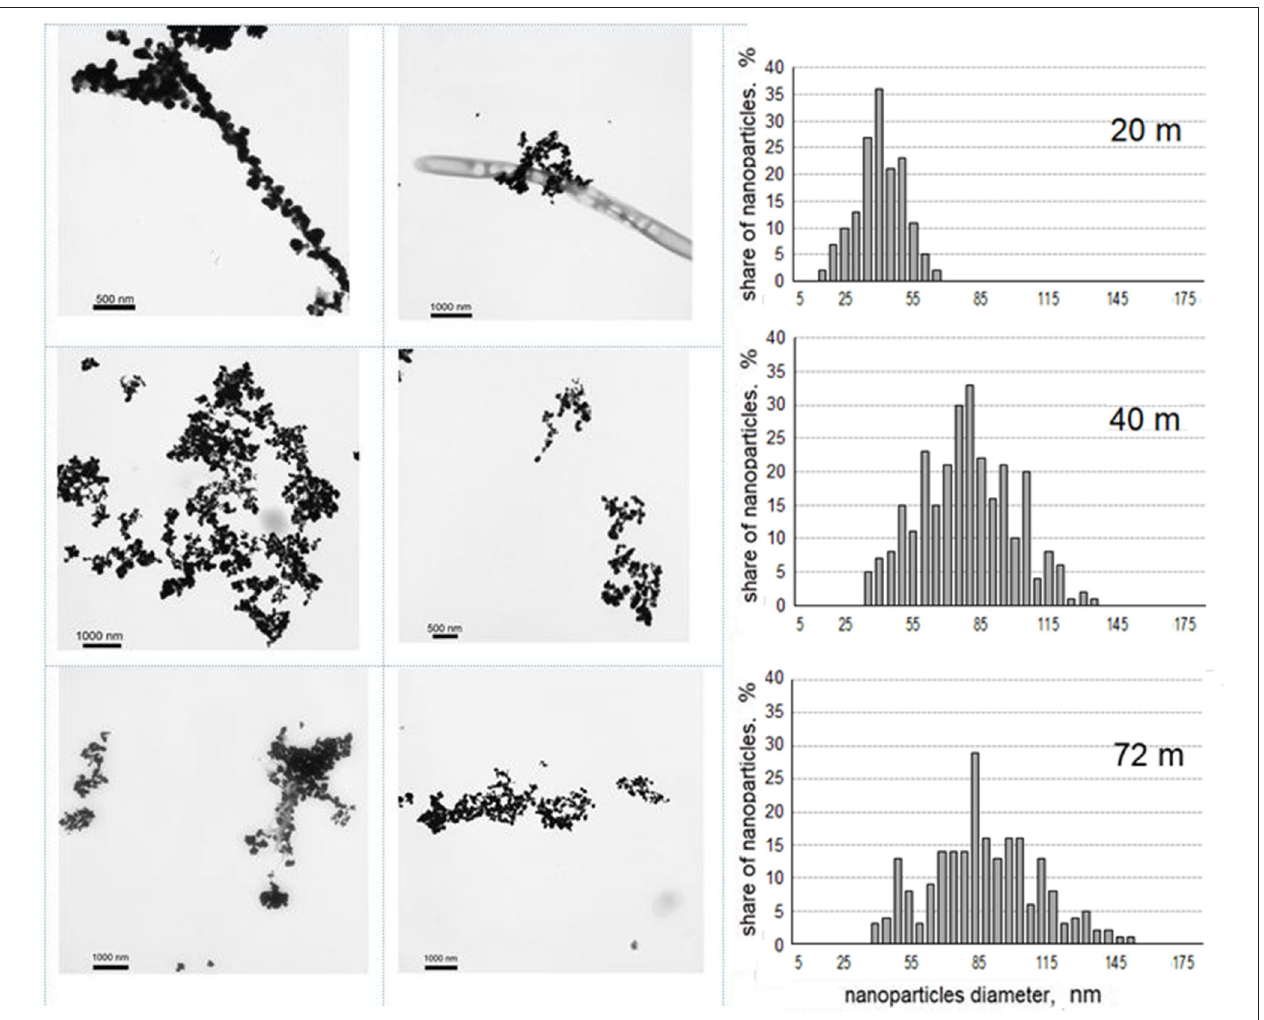
FIGURE 4 | Biogenic Ag ◦ NPs, formed at + 5 ◦ C in 20min in water samples of the Lake Untersee and their distribution in size (in percentage to the total